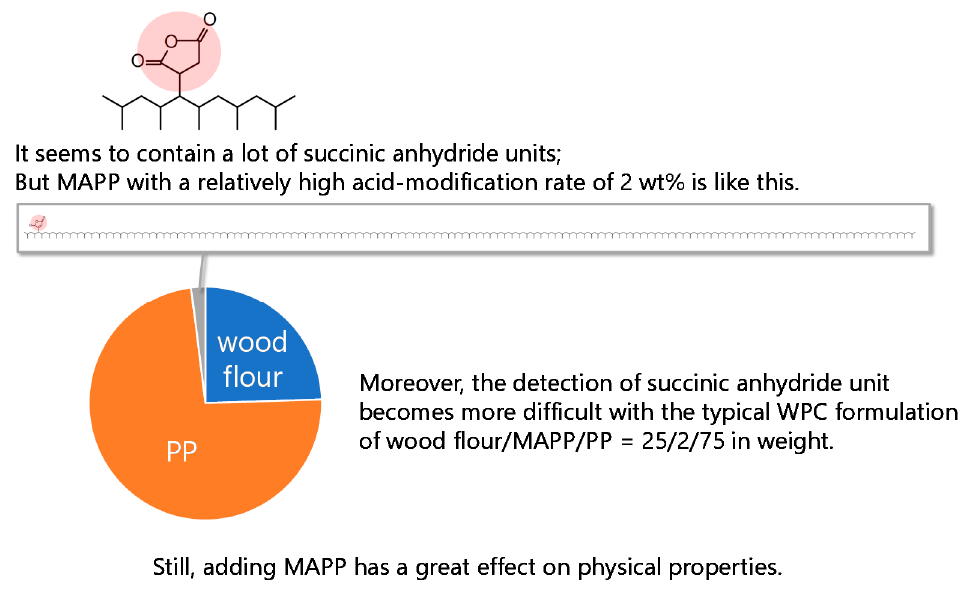
Figure 2. Low concentration of MAPP acid functional groups in WPC.